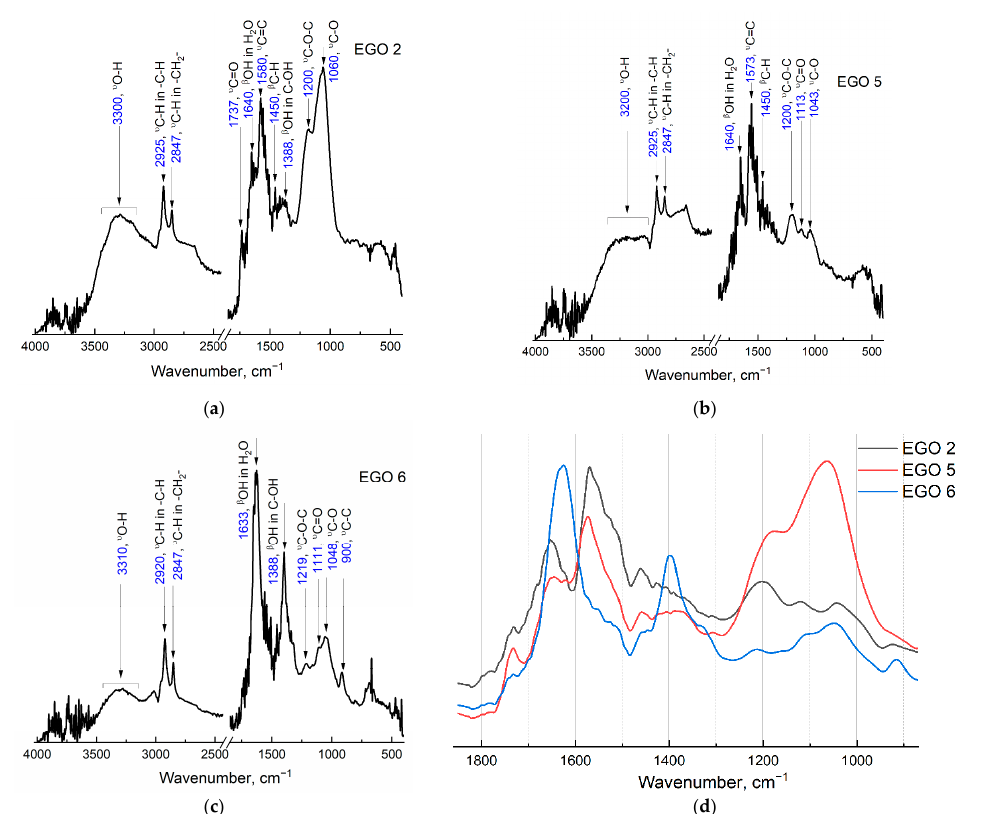
Figure 3. ATR-FTIR spectra of samples: ( a ) EGO 2, two-step synthesis using a separated cathode– anode compartment and additional current transmission using platinum rods as cathode and anode (procedure 3); ( b ) EGO 5, one-step synthesis with a separated cathode–anode compartment without additional current treatment using a platinum rod as an anode (procedure 5); and ( c ) EGO 6, combined cathode–anode compartment (procedure 6). Spectra a, b, and c were recorded in the absorption mode from 4000 to 400 cm − 1 . ( d ) Combined normalized figures for all three EGO samples.